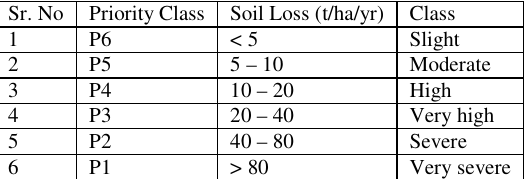
Table 1. Soil Loss Categories according to Average Annual Soil